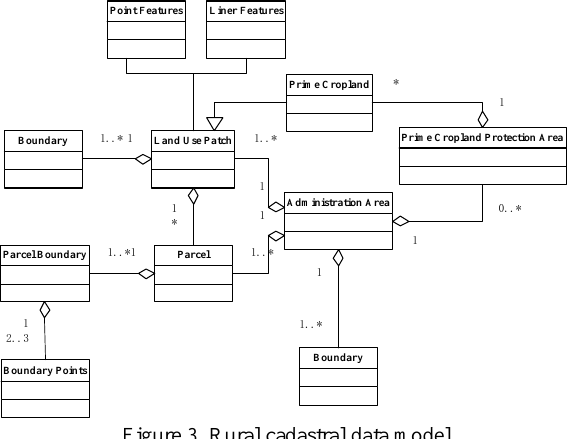
Figure 3. Rural cadastral data